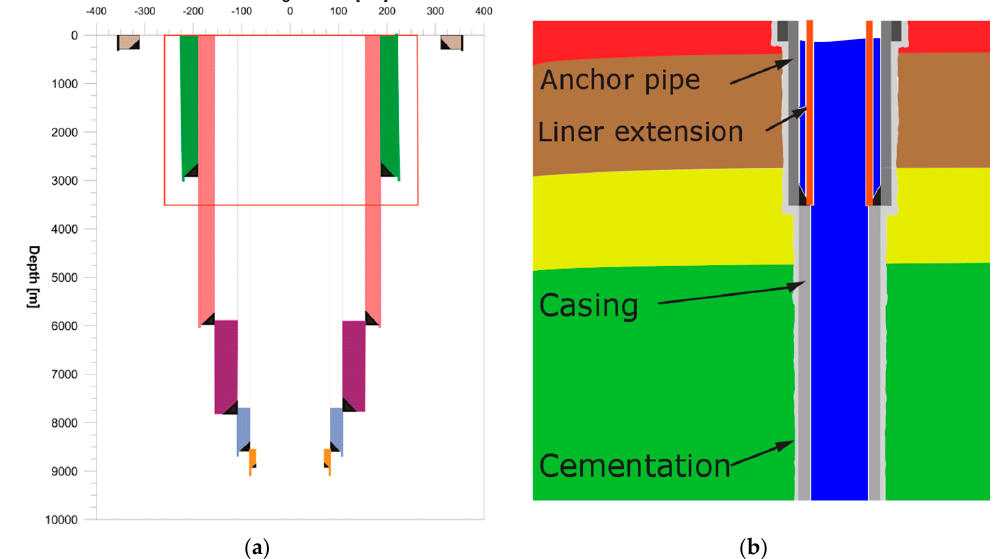
Figure 4. Schematic casing of the KTB site ( a ) and sketch with liner extension ( b ).